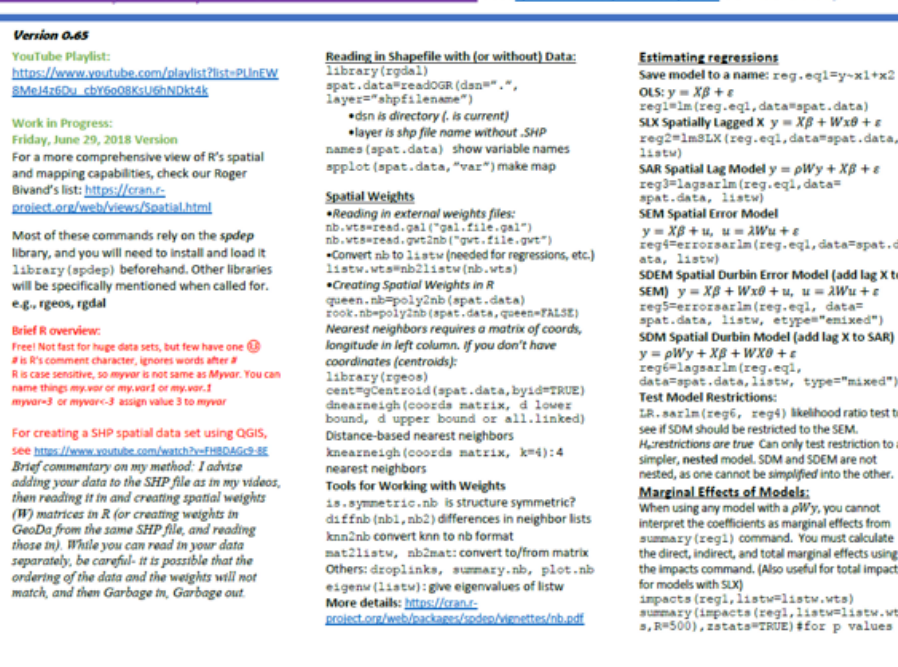
Figure 2: Snapshot of the Spatial Econometrics Cheat Sheet (Burkey